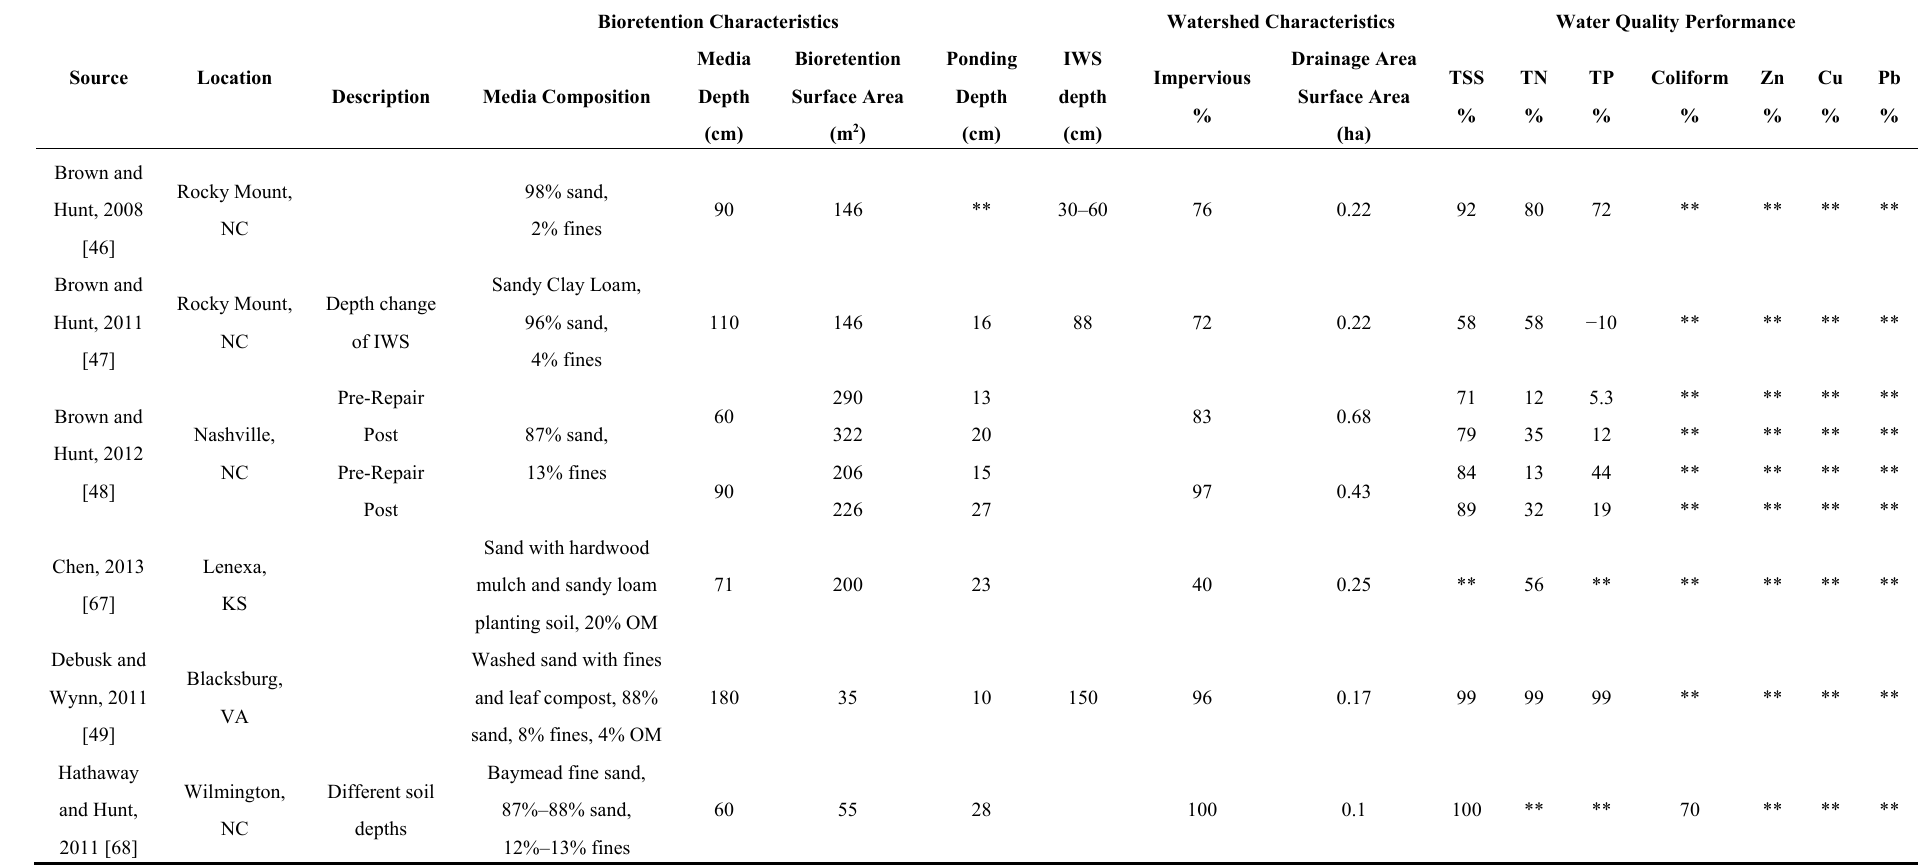
Table 2. Summary of bioretention field studies, water quality